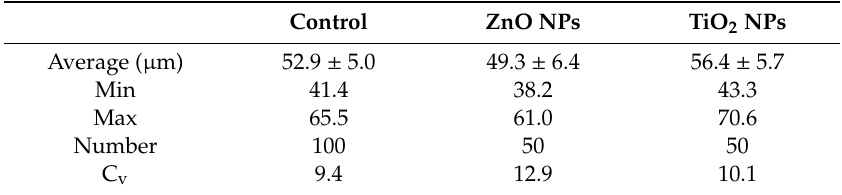
Table 6. Tukey’s HSD average µ m lengths at α = 0.01 for linear glandular trichomes on leaves collected during flower-bud formation after two foliar TiO 2 -NP and ZnO-NP applications, and the NP-free control (Min—minimum, Max—maximum, C v —coe ffi cient of